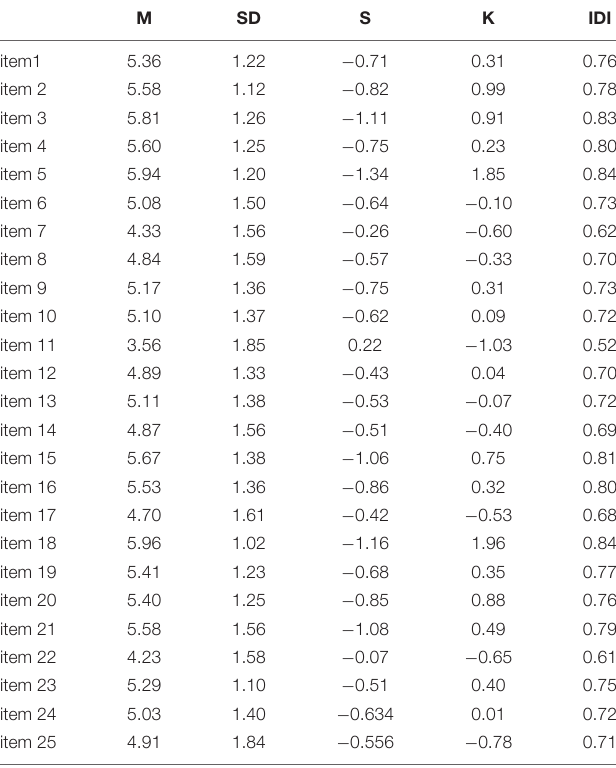
TABLE 1 | Descriptive statistics and the IDI value for individual test